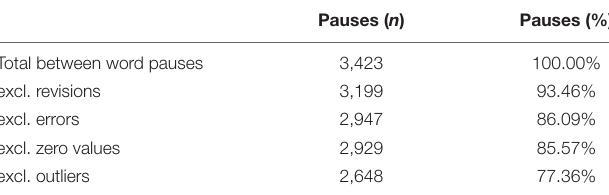
TABLE 2 | Overview of data reduction for between word